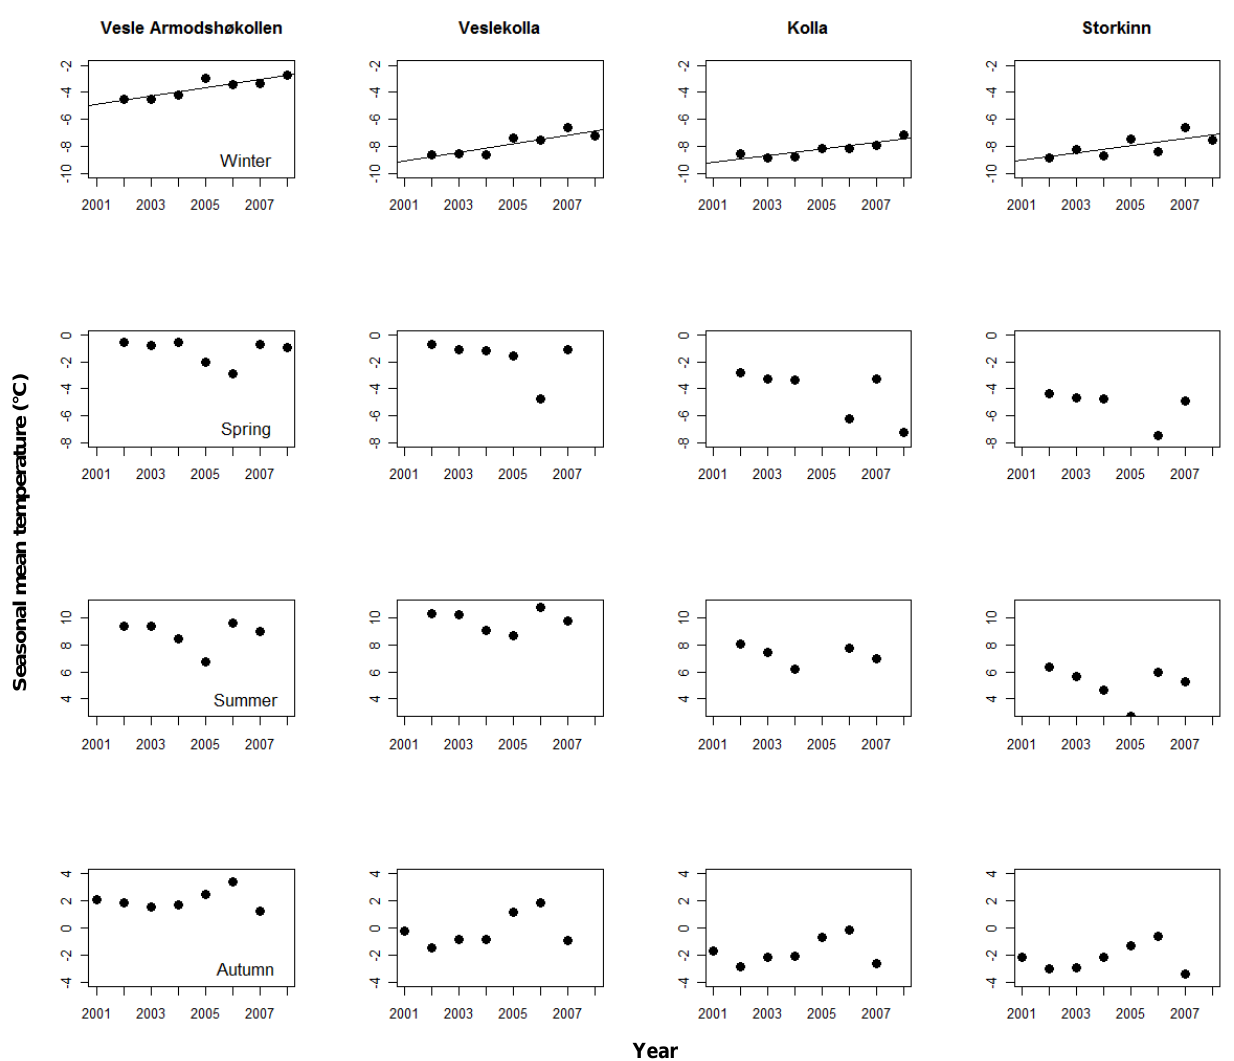
Figure 3. Mean seasonal soil temperatures (ºC) from 2001 to 2008 for winter (December–February), spring (March–May), summer (June–August) and autumn (September–November) at four summits at Dovrefjell. Seasonal temperatures are calculated as means of hourly recordings from each of four loggers placed 5 height meters below the highest summit point in the four cardinal compass directions. Estimated slopes ±95% confidence limits for winter temperatures at Vesle Armodshøkollen, Veslekolla, Kolla and